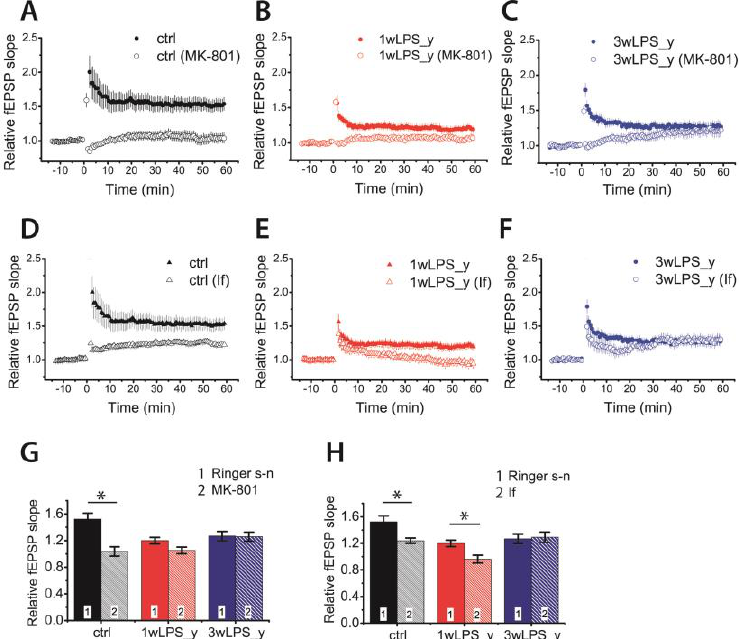
Figure 4. The NMDA receptor (NMDAR)-dependent mechanism of LTP induction is disrupted in the CA1 hippocampus of juvenile animals treated with LPS during the third postnatal week. ( A – C ) The normalized fEPSP slope in the control and experimental groups in the presence of the NMDAR blocker Dizocilpine (MK-801) (10 μM) before and after TBS. ( D – F ) The relative fEPSP slope in the control and experimental groups in the presence of ifenprodil (If, 3 μM), a selective GluN2B-containing NMDAR antagonist, before and after TBS. ( G – H ) Diagrams illustrating the magnitude of plasticity in the control and experimental groups in the presence of MK-801 or ifenprodil. Two-way ANOVA following Tukey post hoc tests were used. * p <